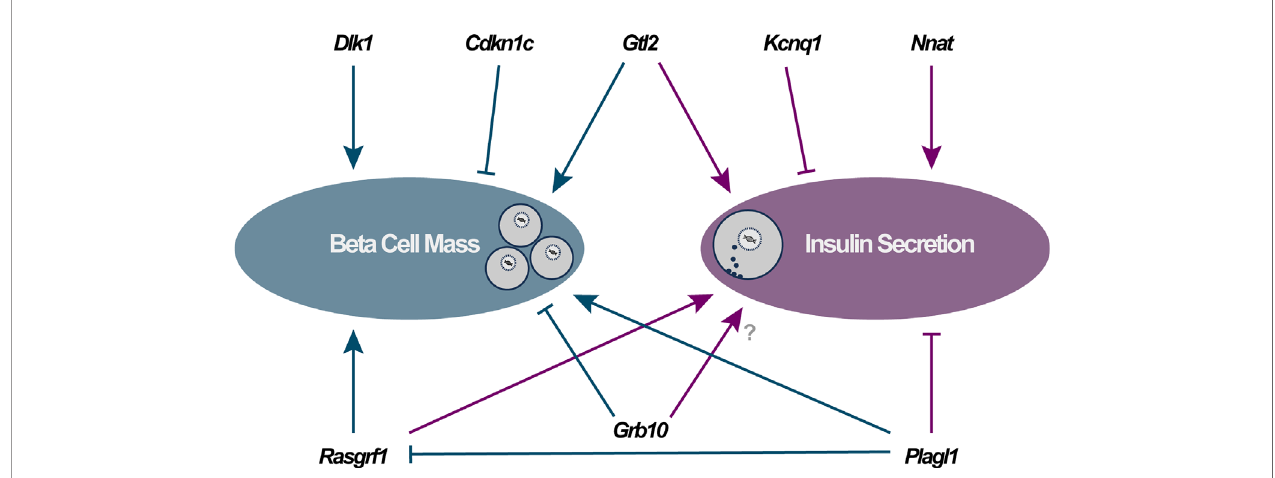
FIGURE 1 | Direct functional importance of imprinted genes in pancreatic beta cells falls into two major categories: modulators of beta cell mass (via changes in cellular proliferation, apoptosis and/or differentiation) and alterations to speci fi c components of the insulin secretory apparatus. Arrowheads and blocked lines represent stimulatory and inhibitory actions on these cellular pathways,